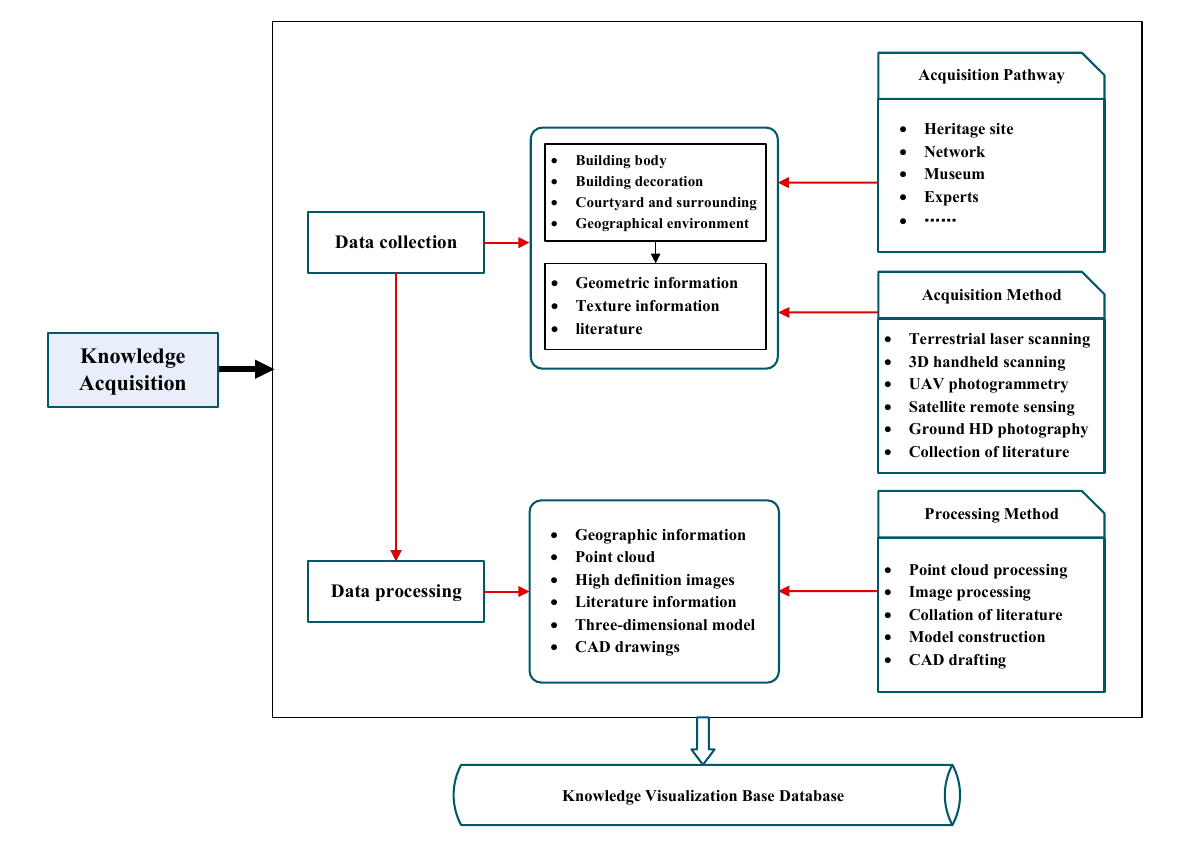
Figure 2. Technical framework of the knowledge